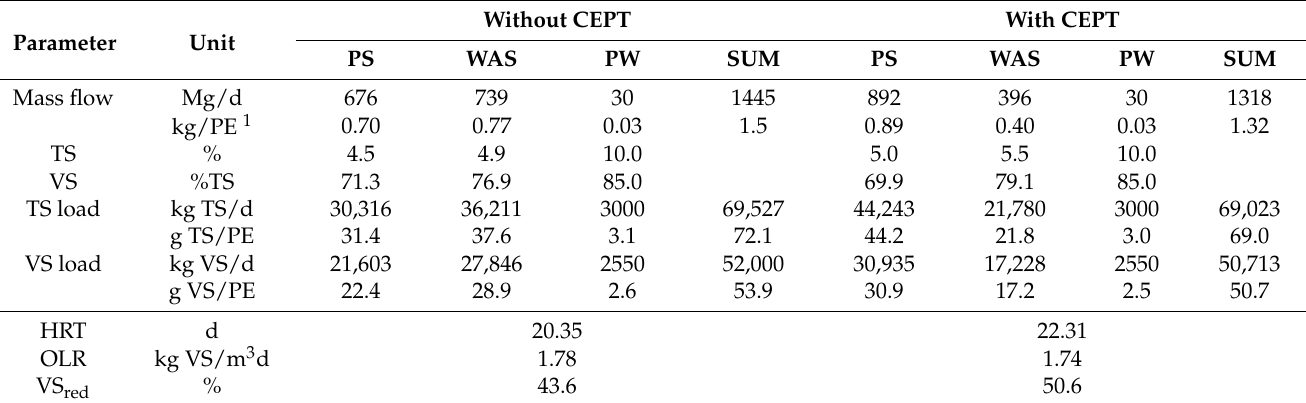
Table 3. Input for anaerobic digestion (AD) with and without CEPT application.